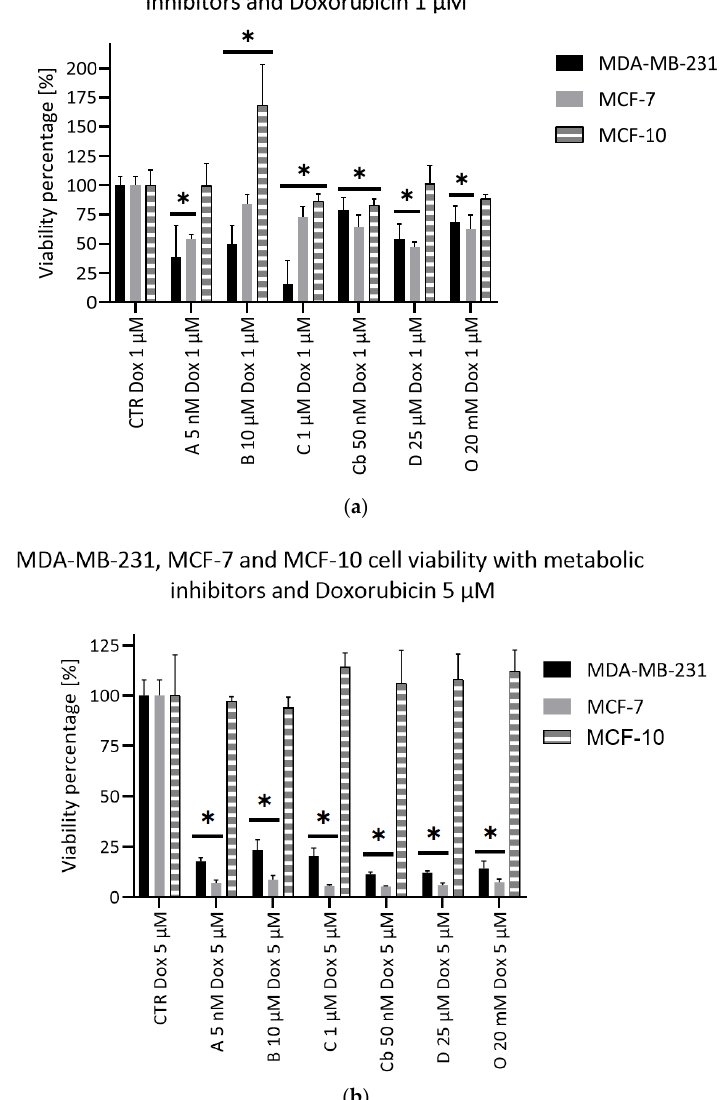
Figure 5. Potentiation of Doxorubicin ( a ) 1 µ M and ( b ) 5 µ M thanks to the metabolic inhibitors after 72 h (crystal violet staining). Black: MDA-MB-231, Grey: MCF-7 and Hatched: MCF-10. CTR: control condition. A: AZD3965, B: 3-bromopyruvate, C: Chrysin, Cb: CB-839, D: D609, O: Oxamate and Dox: Doxorubicin; n = 6, average ± SD, significance: * p <